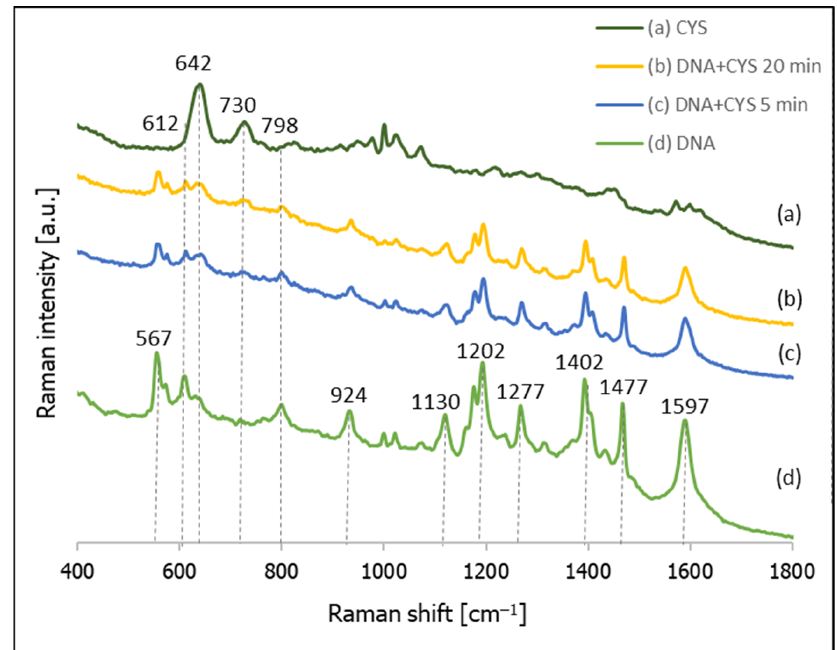
Figure 9. SERS spectra of layers formed on a nanostructured silver surface from: ( a ) a 10 mM cysteamine solution, ( b ) thiolated DNA labelled with Cy3 and immersed for 20 min in a 10 mM cysteamine solution, ( c ) thiolated DNA labelled with Cy3 and immersed for 5 min in a 10 mM cysteamine solution, and ( d ) thiolated DNA labelled with Cy3.